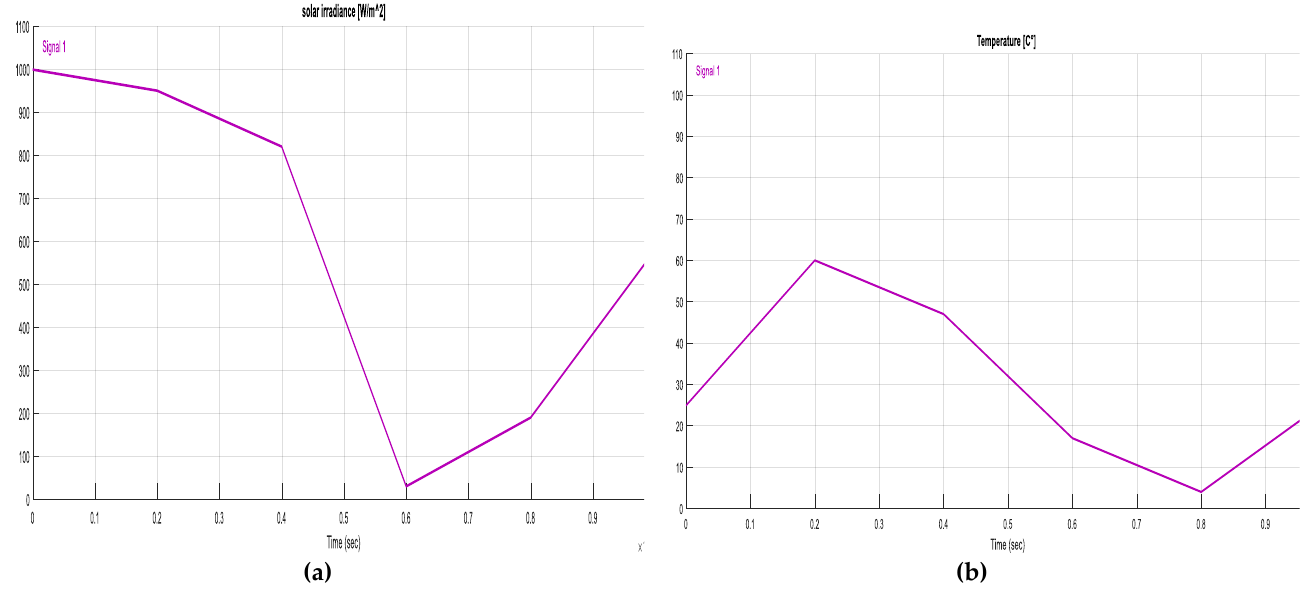
Figure 10. Solar irradiance and temperature variation: ( a ) Solar irradiance variation, ( b ) Temperature variation .